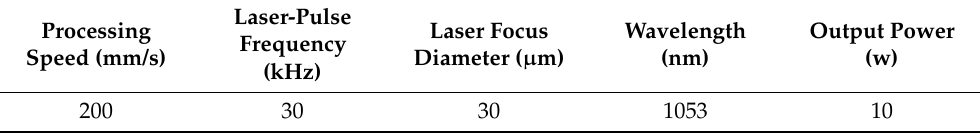
Table 2. The technological parameters for laser texturing processing.